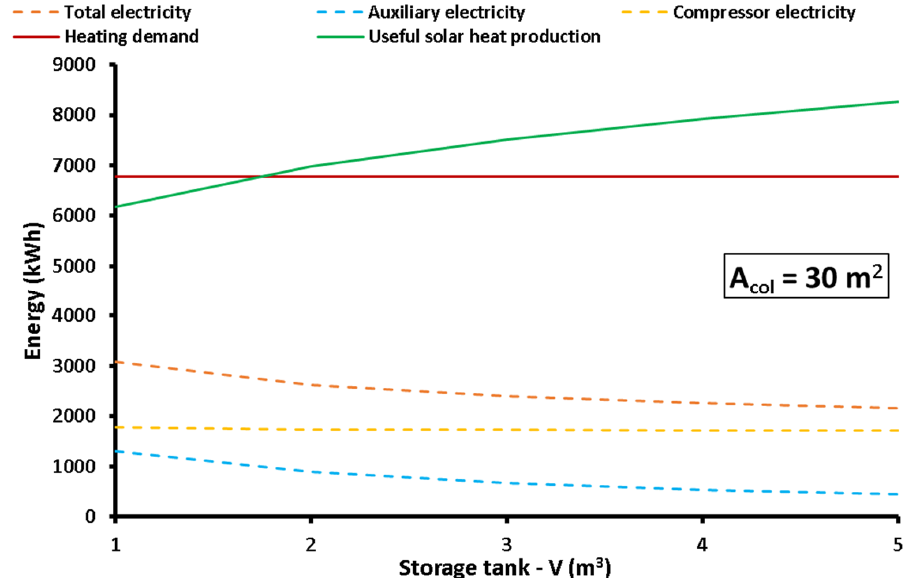
Figure 10. Variation in energy quantities for different storage tank volumes with the collecting area at 30 m 2 .